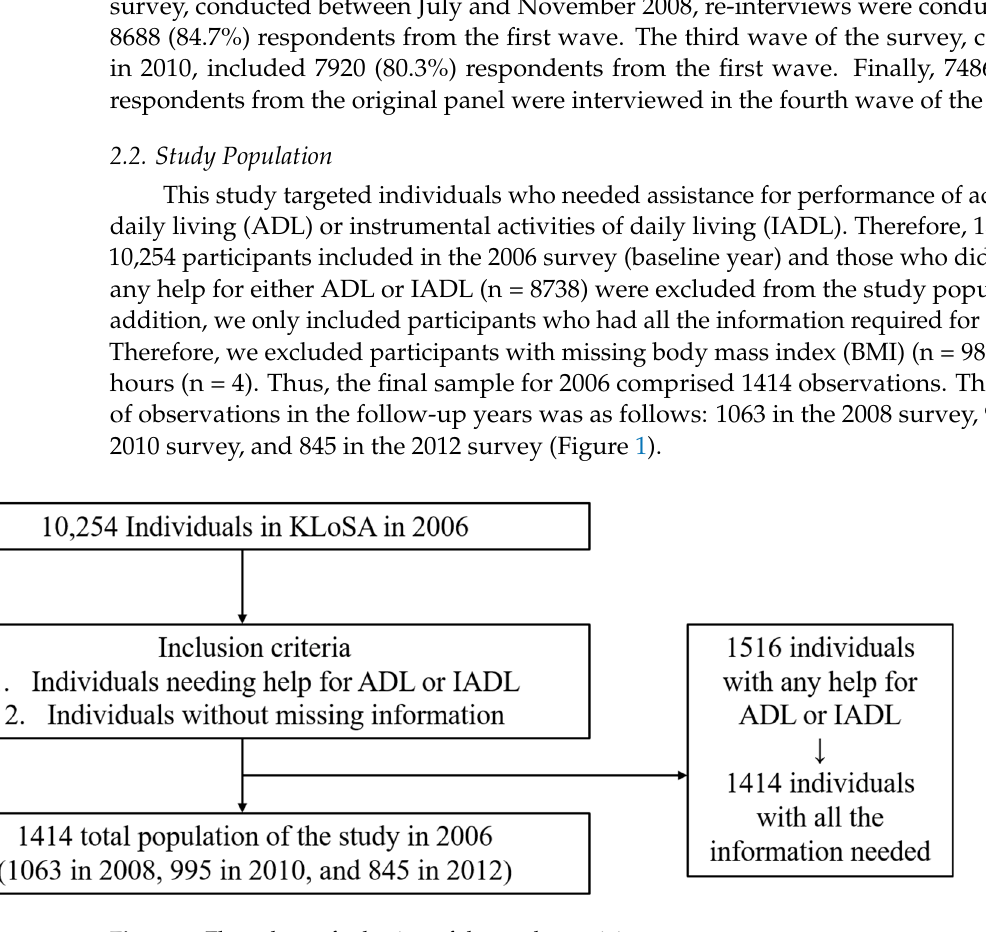
Figure 1. Flow chart of selection of the study participants.